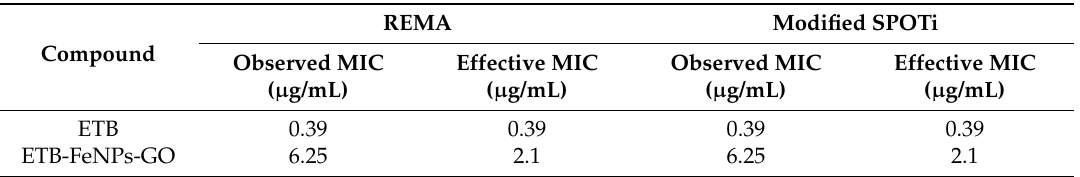
Table 2: The minimum inhibitory concentration of the compounds tested based on the liquid Resazurin Microtiter Assay (REMA) assay with M. smegmatis.